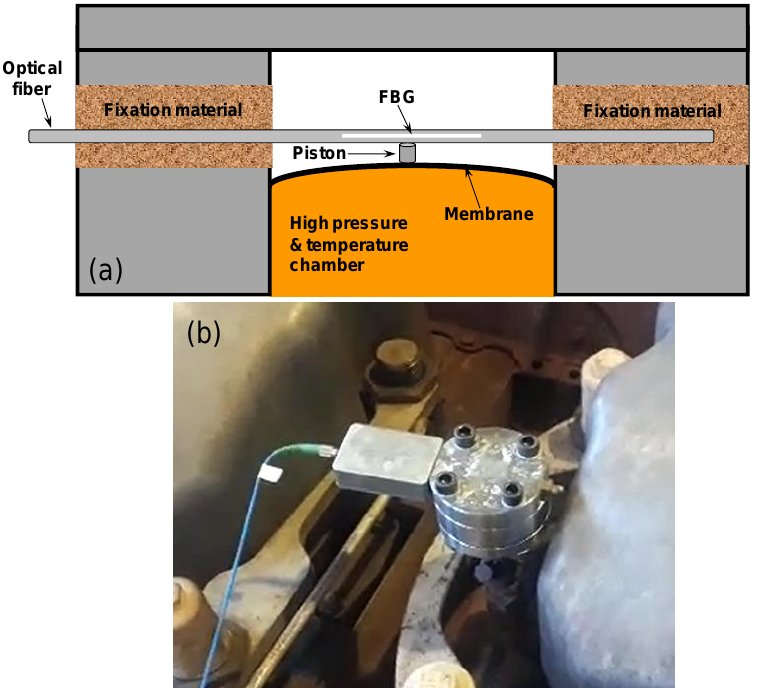
Figure 8. ( a ) Scheme of the FBG pressure sensor and ( b ) sensor connected in the pressure monitoring point of the engine.